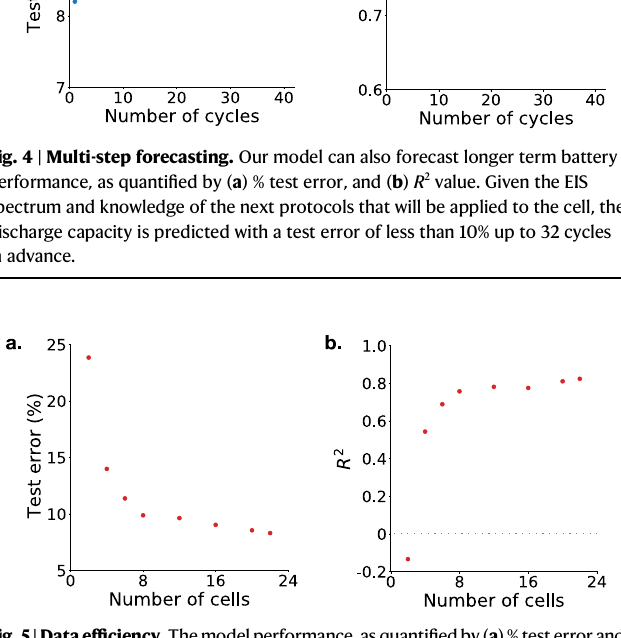
Fig.5|Dataef fi ciency. Themodelperformance,asquanti fi edby( a )%testerrorand ( b ) R 2 , improves as the number of cells used to train increases. The model is data- ef fi cient,achievingatesterroroflessthan10%withjusteightcellsinthetrainingset.